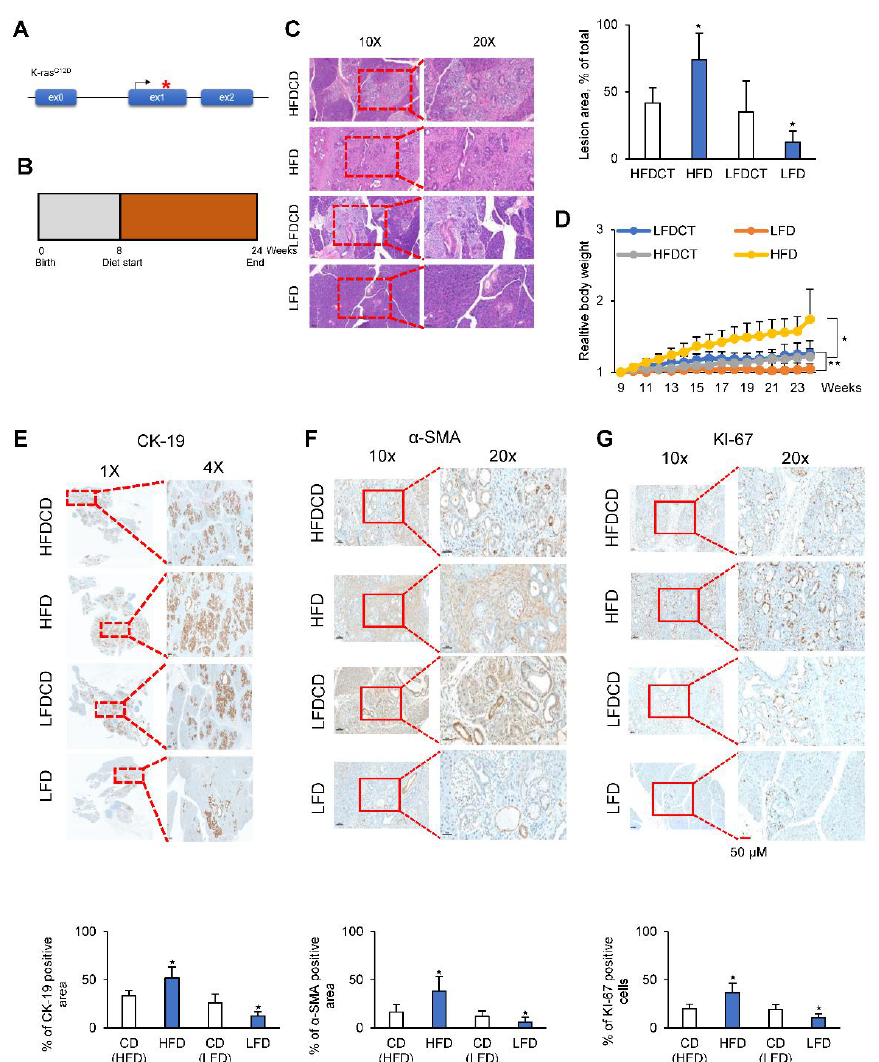
Figure 7. A low-fat diet abrogated spontaneous tumor formation in a KC mouse model. ( A ) Schematic illustration of the genetic construct used to activate Kras G12D in the pancreas of KC mice. ( B ) Schematic showing the experimental design of diet protocols in KC mice for 24 weeks. ( C ) H&E staining of the pancreas in calorie balanced CD, HFD, and LFD mice, and quantification of the percentage of PanlN lesions (left). Lesion area was analyzed by software and presented as % of the total area (right). ( D ) Changes in body weight of Kras G12D ; Pdx1 -cre mice for 24 weeks in calorie balanced CD, HFD, and LFD. ( E – G ) Staining of the pancreas in CD, HFD, and LFD mice using antibodies of CK-19 as a ductal epithelial marker, α -SMA as a stromal fibrosis marker, and KI-67 as a proliferation marker. LFD, low-fat diet; HFD, high-fat diet; LFDCD and HFDCD, control diets of low fat diet and high fat diet. Scale bar = 50 µ m * p < 0.05, ** p <